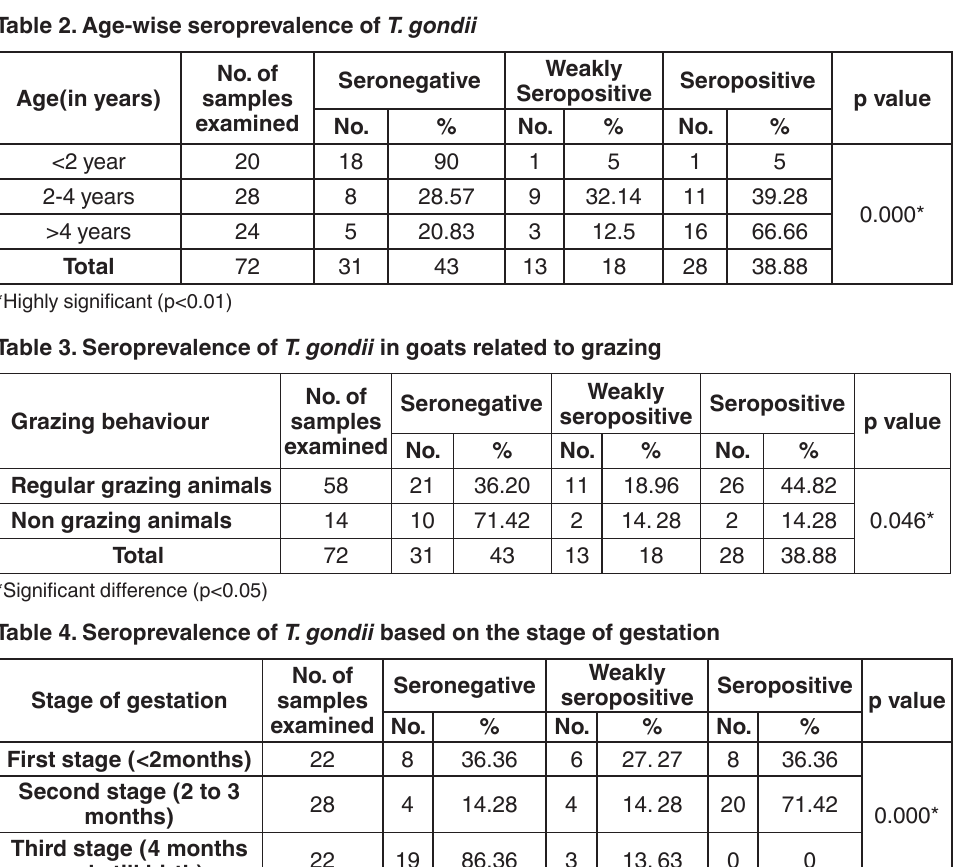
Weakly seropositive